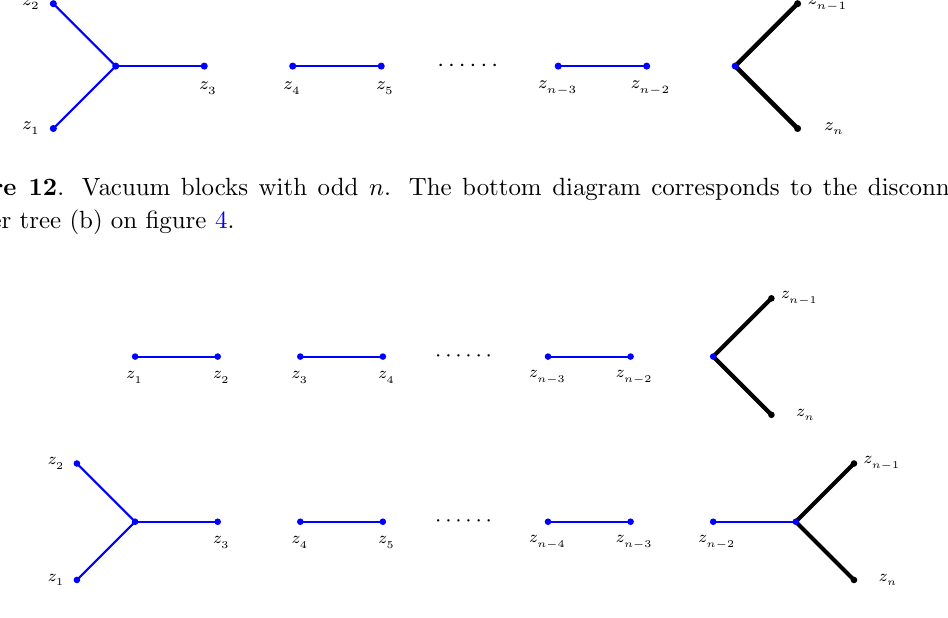
Figure 7 . i -th identity block: ˜ ✏ i = 0, the zeroth channel is shown in red.